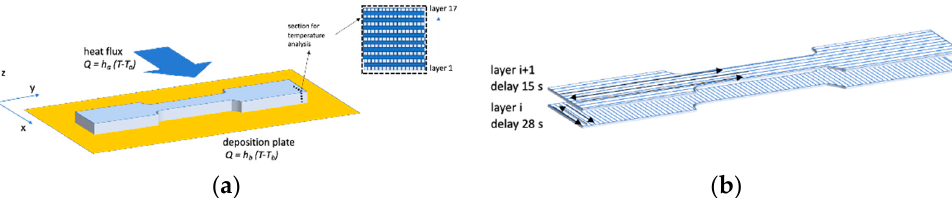
Figure 3. ( a ) Sketch of the boundary conditions adopted in the model for the simulation of the temperature evolutions during deposition. ( b ) Sketch of the deposition direction and delay times adopted for each layer.